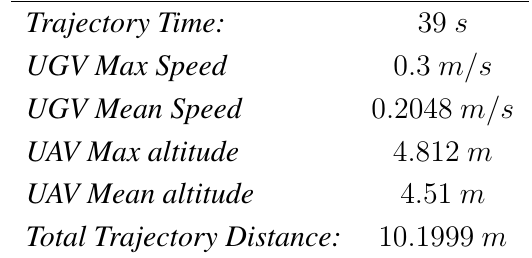
Table 4. Trajectory Parameters and Additional